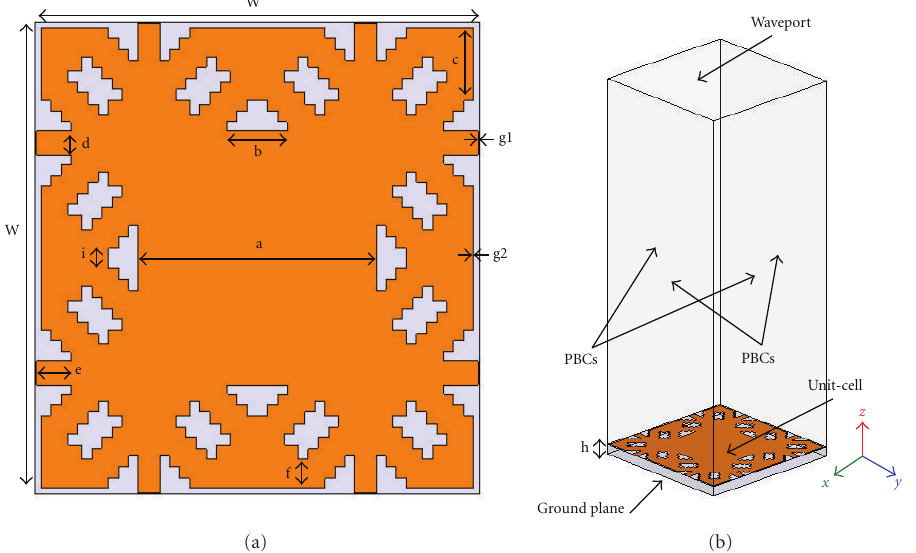
Figure 1: AMC unit-cell design: (a) unit-cell geometry top view and (b) simulation